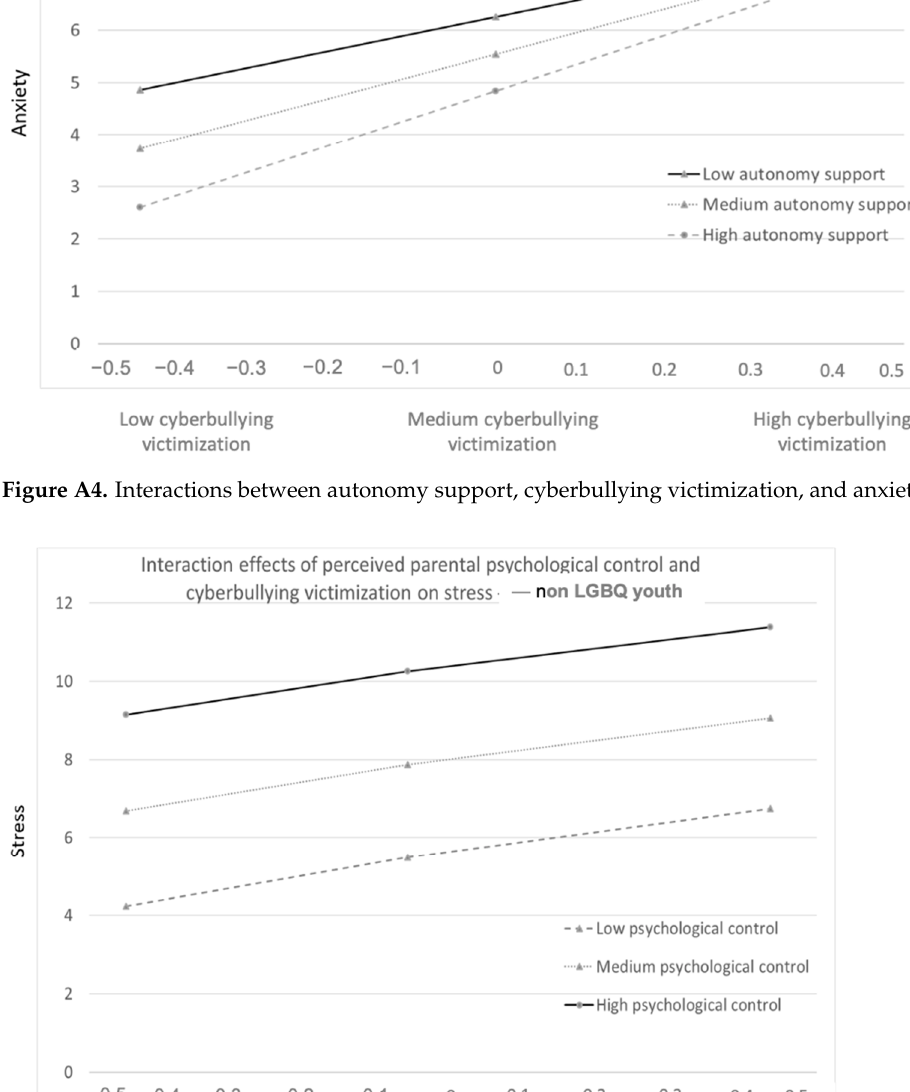
Figure A5. Interactions between psychological control, cyberbullying victimization, and stress among heterosexual (non-LGBQ) youth. Bold: It is to point out that these findings were only found for non-LGBQ youth.